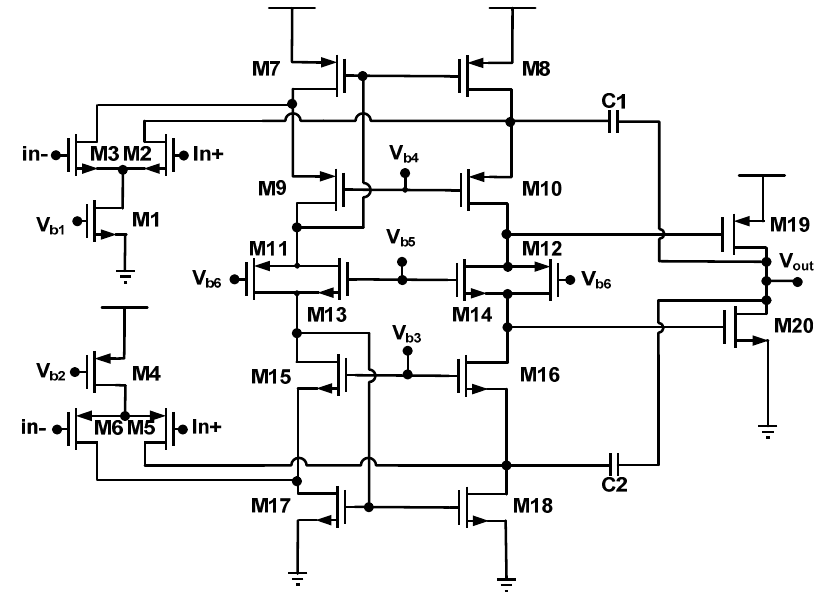
Figure 3. Low-voltage two-stage cascaded operational amplifier with Miller compensation and compact class-AB output stage.